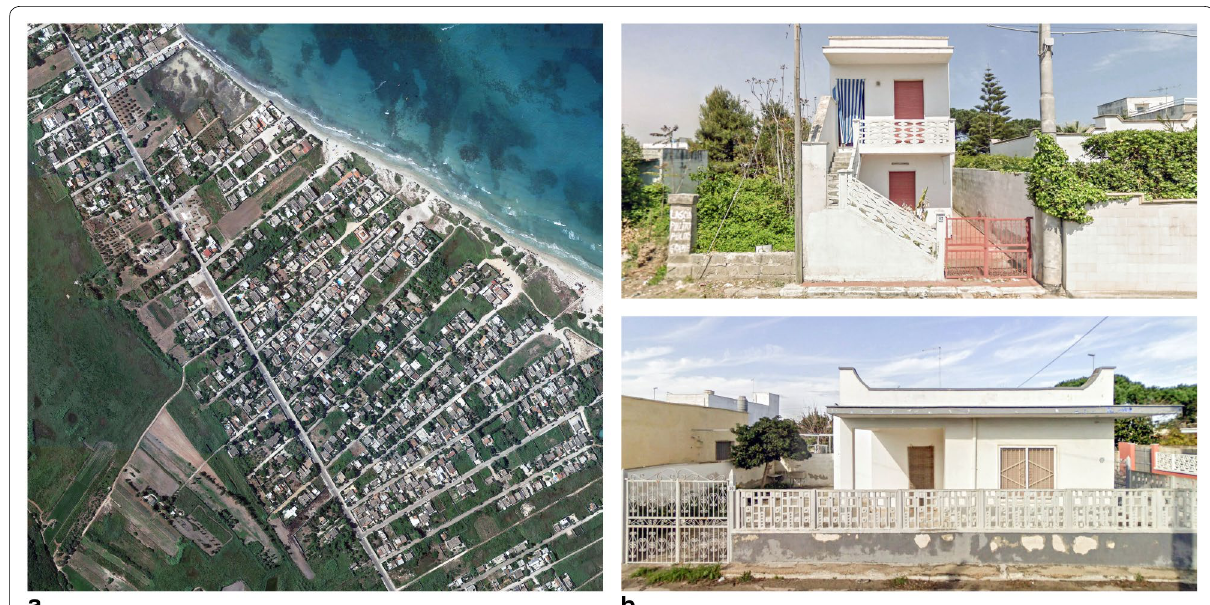
Fig. 11 a Municipality of Lecce, 1 1 km sample. Secondary-houses coastal settlement (Google Earth). b Municipality of Lecce, seasonal Family × houses along the coast (Google Street